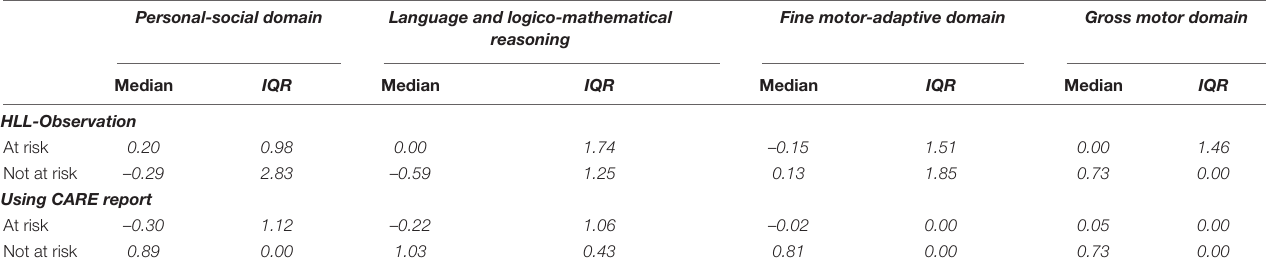
TABLE 5 | Median and data spread (Interquartile range-IQR) for the Net percentage change index (NET) between scores for Haizea-Llevant (HLL) and CARE report by developmental dimensions. Personal-social domain Language and logico-mathematical reasoning